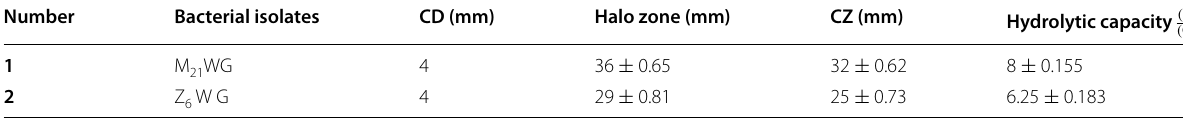
All tests were performed in triplicate described by mean CD colony diameter, CZ clear zone, mm